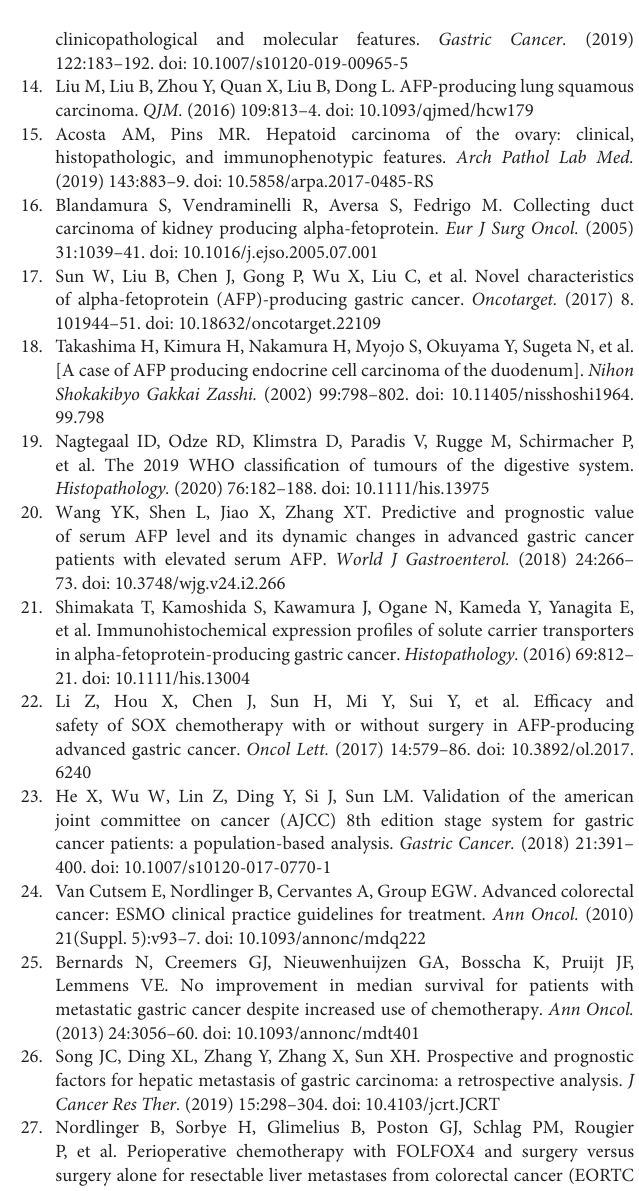
Supplementary Figure 1 | Kaplan–Meier curve of HA positive and HA negative within APA-GI Comparison of survival between HA positive and HA negative within 73 APA-GI patients who received operation. Supplementary Figure 2 | Typical immunohistochemical staining images of APA-GI a, Negative; b, Weakly positive; c, Moderately positive; d, Strongly positive. Supplementary Figure 3 | Kaplan–Meier curve of AFP-/HA- between the other patients within APA-GI. Comparison of survival between AFP-/HA- and the other patients within 73 APA-GI patients who received operation.